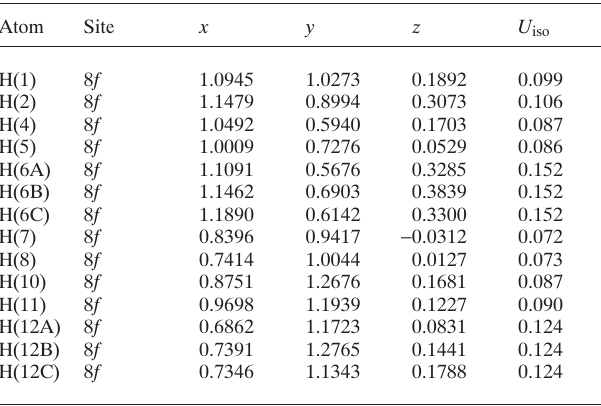
Table 2. Atomic coordinates and displacement parameters (in Å 2 )